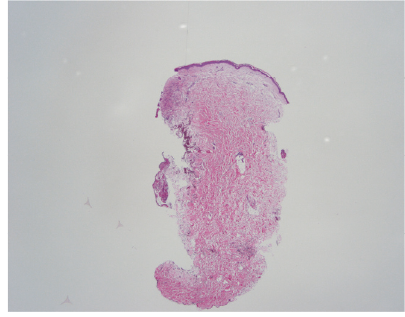
Figure 1: Maculopapular rash.